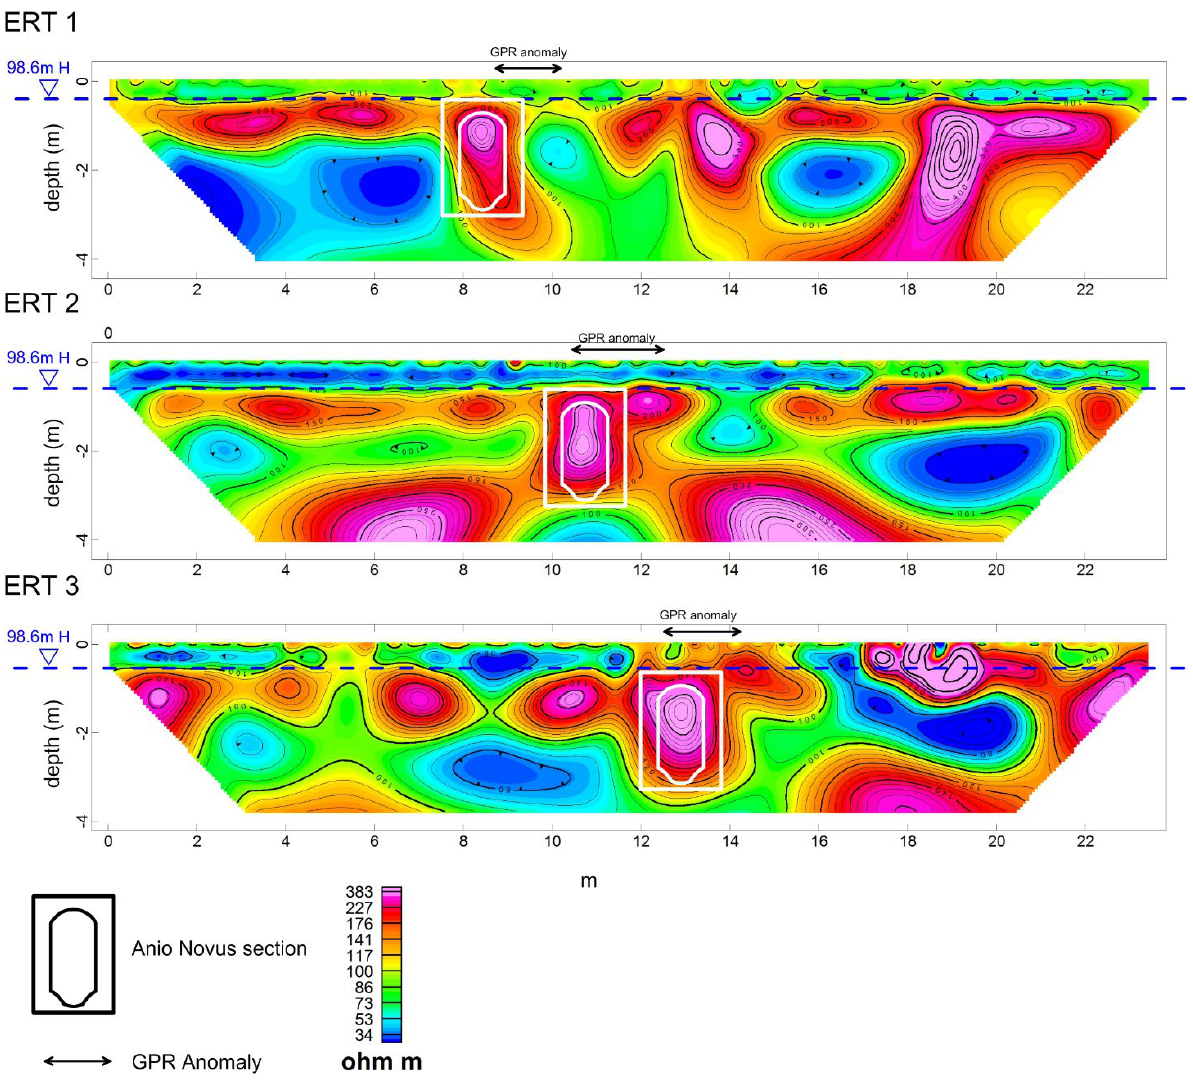
Figure 7 . The inversion results for the 3 profiles over the Anio Novus